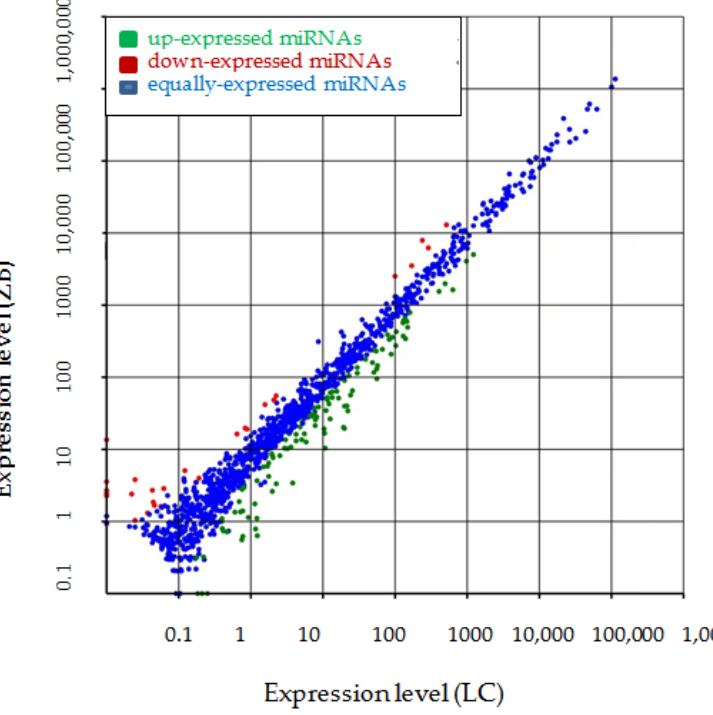
Figure 2. Scatter plot of expressed miRNAs in two cashmere goat breeds. In order to test the small RNA-seq results, the abundance of 17 differentially expressed miRNAs screened from small RNA-seq were further detected using RT-qPCR analysis. After comparison, the RT-qPCR results were identical to those originated from small RNA- seq (Figure 3). These results further confirm the reliability and repeatability of small RNA-seq